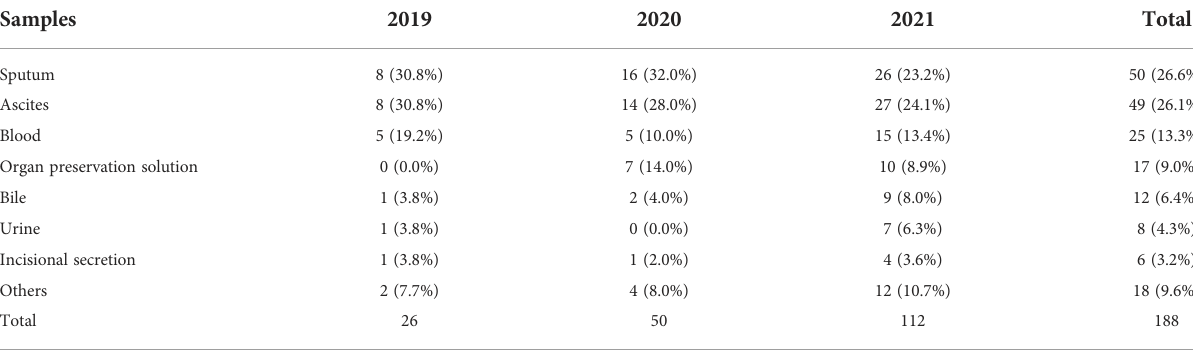
TABLE 2 Clinical specimens in which bacteria pathogens detected.